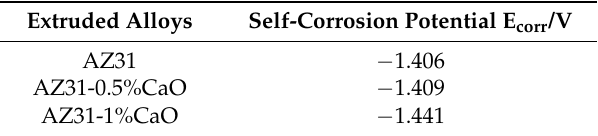
Table 2. Self-corrosion potential of extruded alloys.